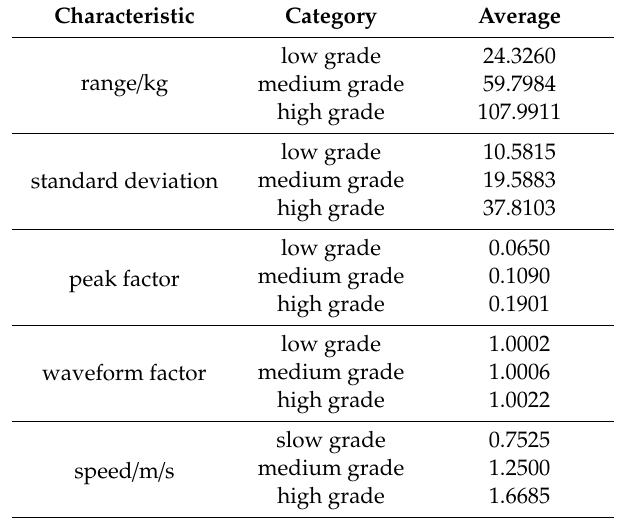
Table 1. Average values for three motion states with di ff erent